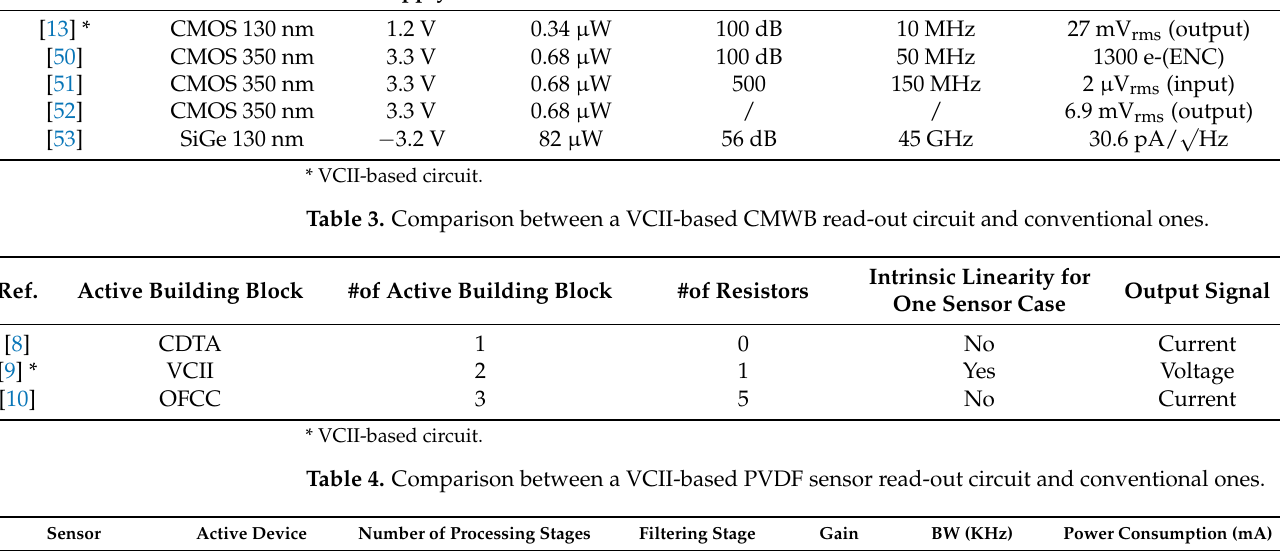
Table 2. Comparison between a VCII-based SiPM read-out circuit and conventional ones. Ref.